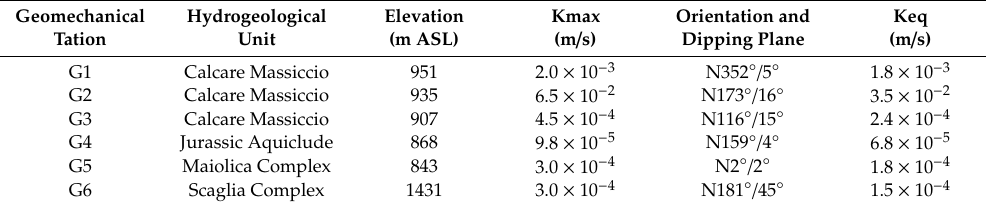
Table 1. Values of Kmax and Keq derived from the geomechanical survey. The dipping plane is expressed in terms of direction and inclination of the linear element (Kmax